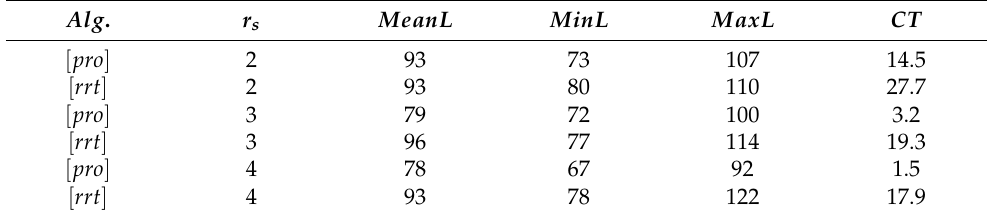
Table 3. MATLAB simulation results with varying r s (scenario 1).